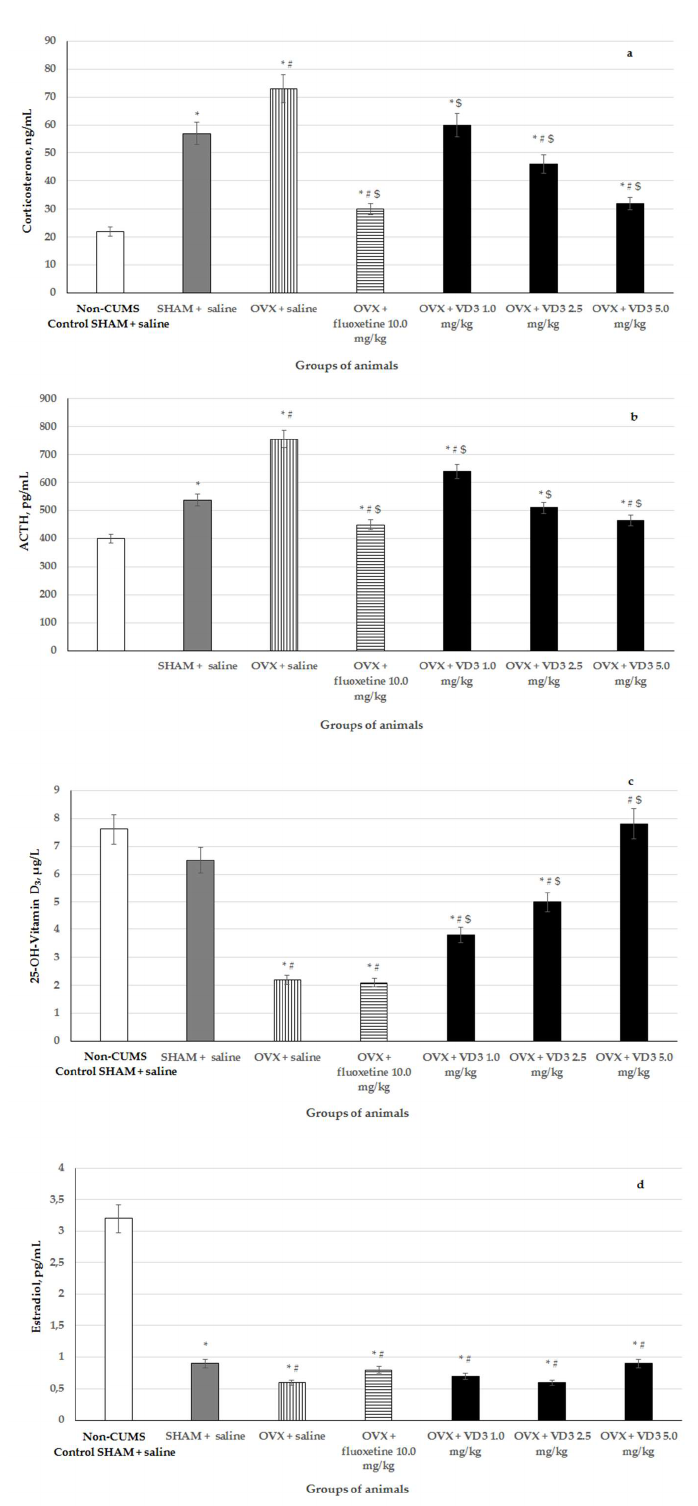
Figure 6. E ff ects of VD 3 administered in various doses on serum corticosterone, ACTH, estradiol and 25-OH-VD 3 levels in the long-term OVX rats subjected to CUMS. ( a )—Corticosterone, ng / mL, ( b )—ACTH, pg / mL, ( c )—25-OH-Vitamin D 3 , µ g / mL, ( d )—Estradiol, pg / mL. *— p < 0.05 versus the non-CUMS SHAM group (control group) treated with saline, #— p < 0.05 versus the SHAM group with CUMS treated with saline, $— p < 0.05 versus the long-term OVX group with CUMS treated with saline. The data are presented as the mean ± SD; n = 7 in each